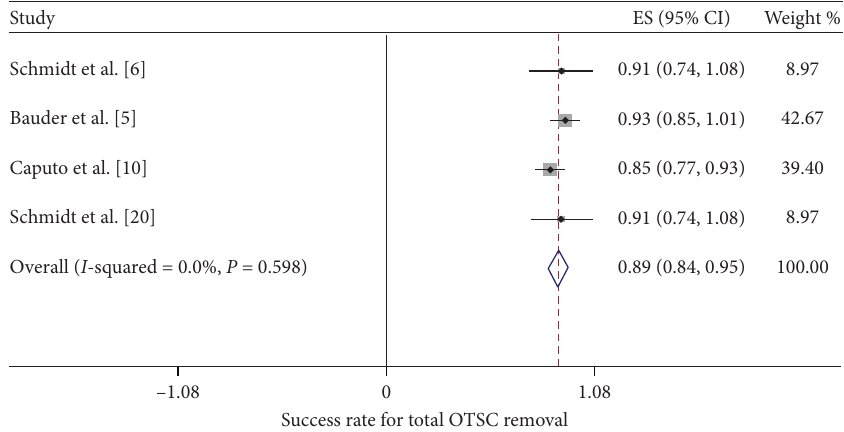
Figure 4: The pooled success rate for total OTSC removal by the remOVE